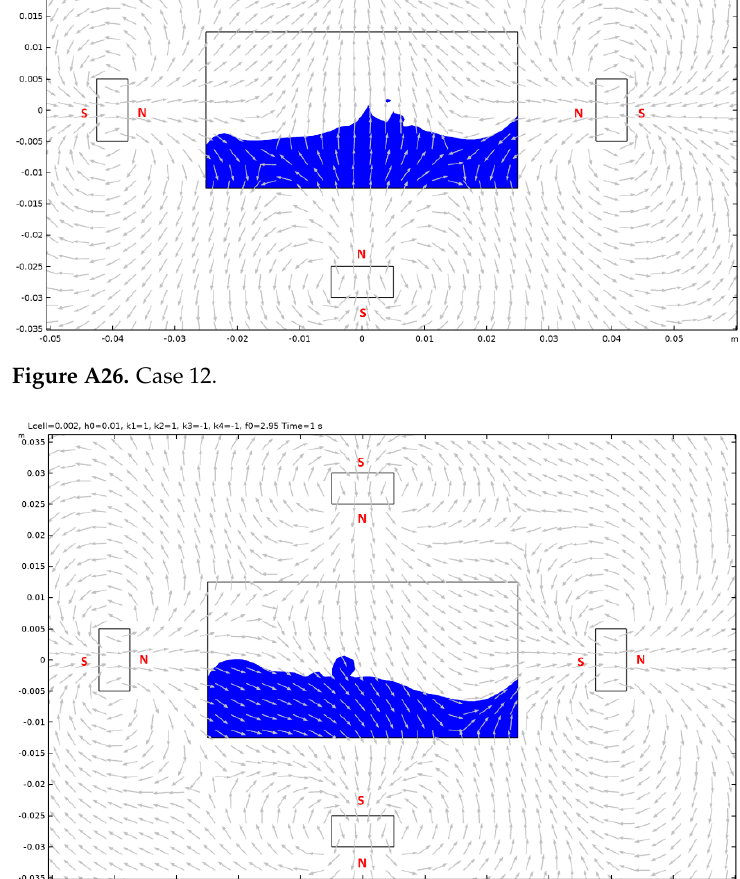
Figure A27. Case Figure A27. Case 13. Figure A27. Case 13.